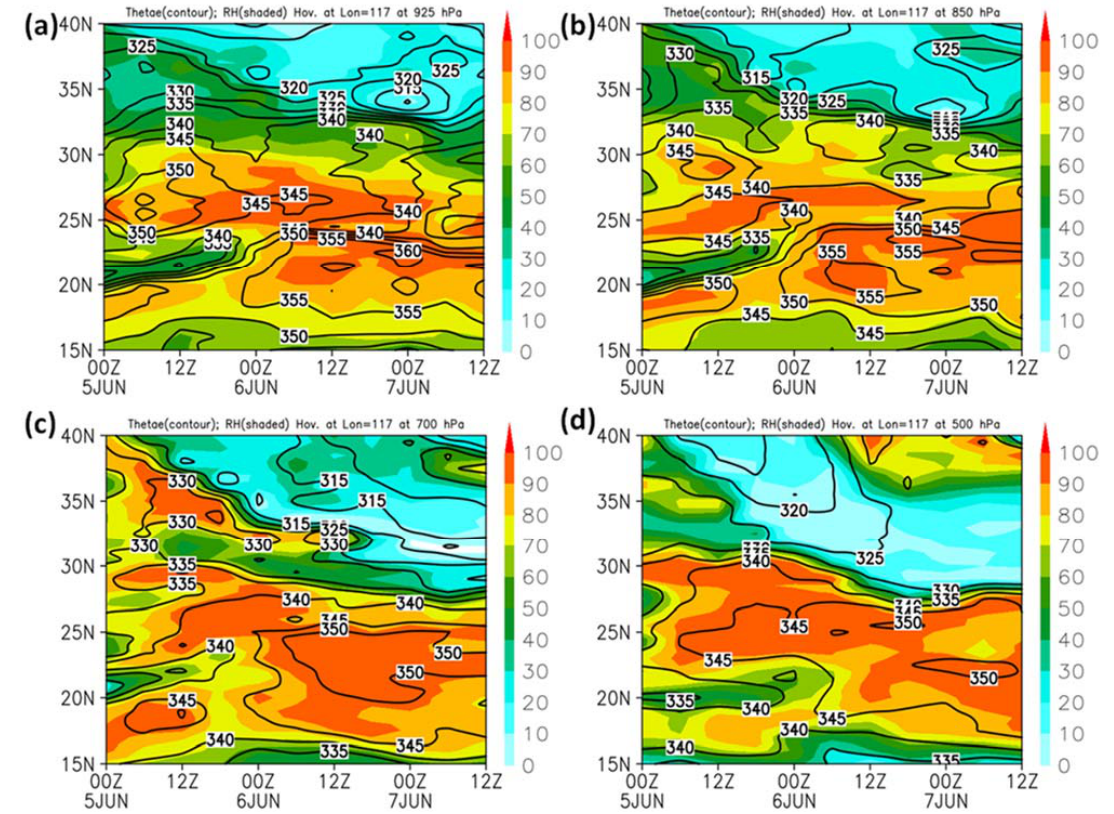
Figure 6. The CFSR latitude–time cross ‐ section along 117° E for equivalent potential temperature (K, contoured every 5 K) and relative humidity (shaded every 10%) at ( a ) 925 hPa; ( b ) 850 hPa; ( c ) 700 hPa; and ( d ) 500 hPa.